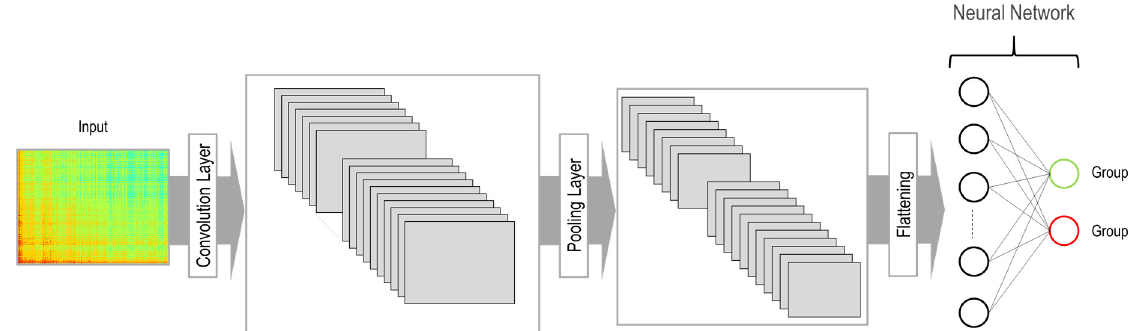
Figure 12. Architecture of the CNN model.